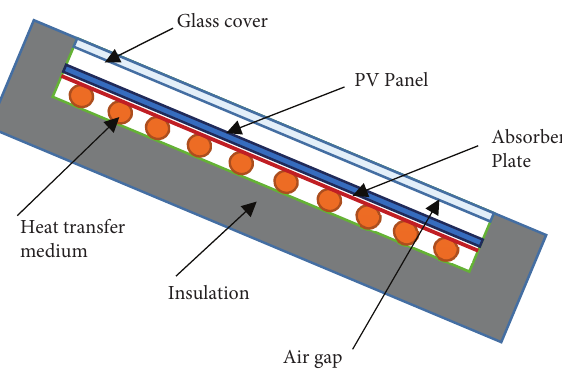
Figure 1. Sketch of the flat-plate PV/T collector model with six